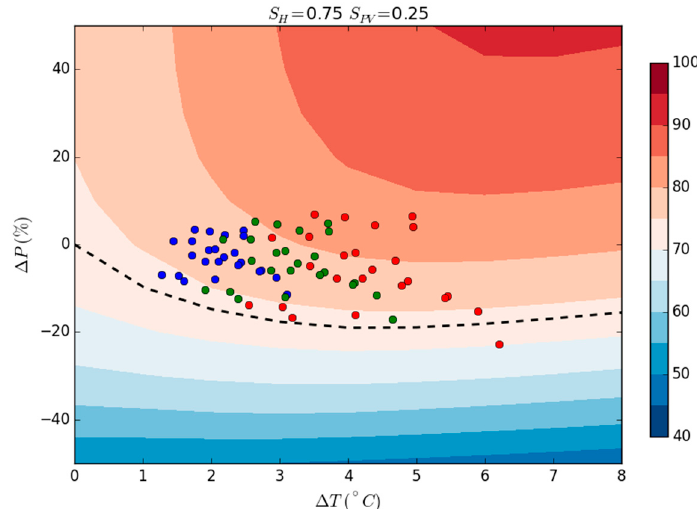
Figure 9. Climate Response Function of the penetration rate (%) when power generation comes from 25% of solar PV and 75% of RoR power (i.e., S PV = 0.25). 75% of RoR power comes the alpine catchment (i.e., S H = 0.75). Dots show the temperature and precipitation changes expected from CMIP5 experiments as illustrated on Figure 4. Dashed black line shows ‘no penetration change’ edge.